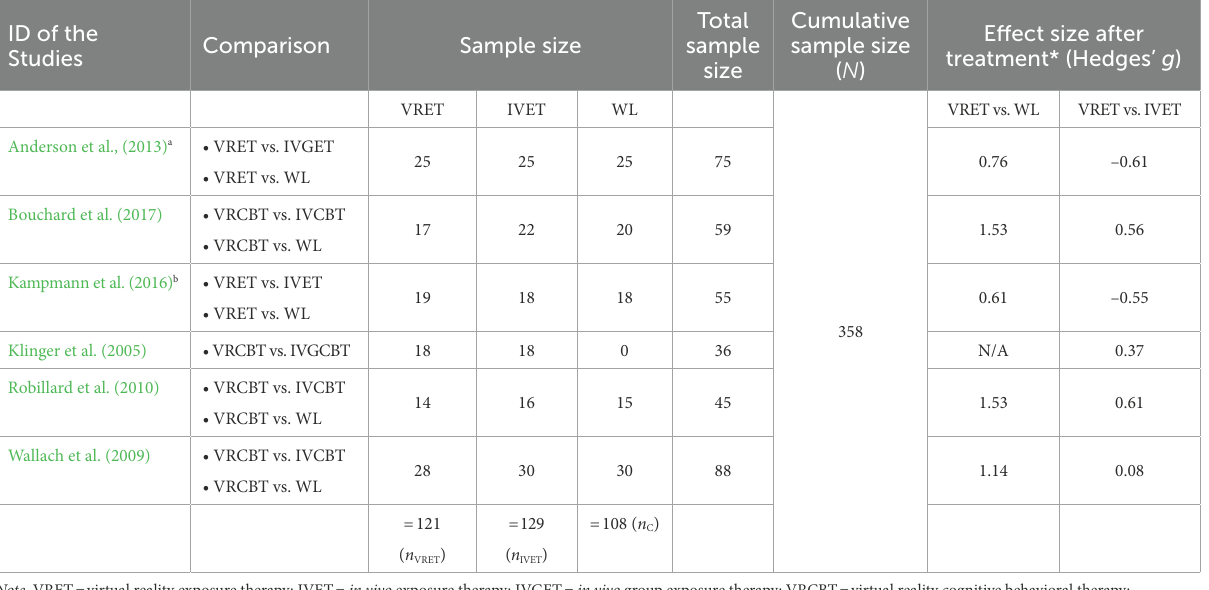
TABLE 1 Virtual reality exposure therapy (VRET) for the treatment of social anxiety disorder (SAD): randomized controlled comparative studies. ID of the